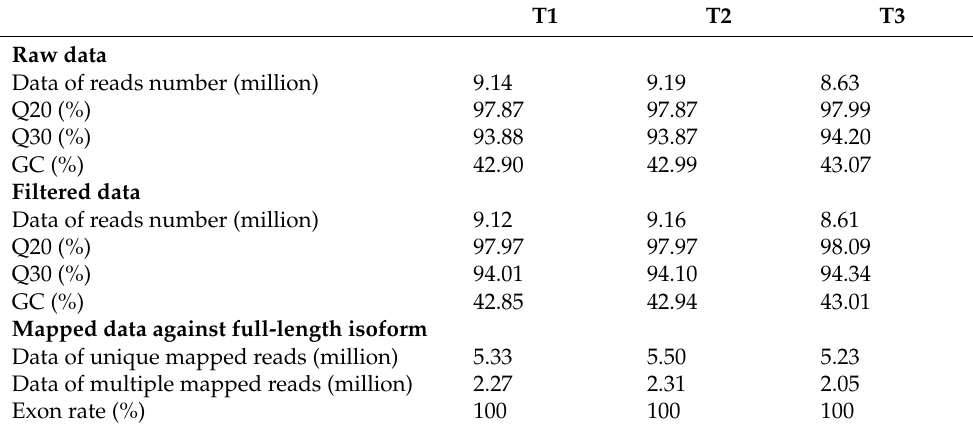
Table 1. Summary of Illumina sequencing data of A. sinensis for T1, T2 and T3.